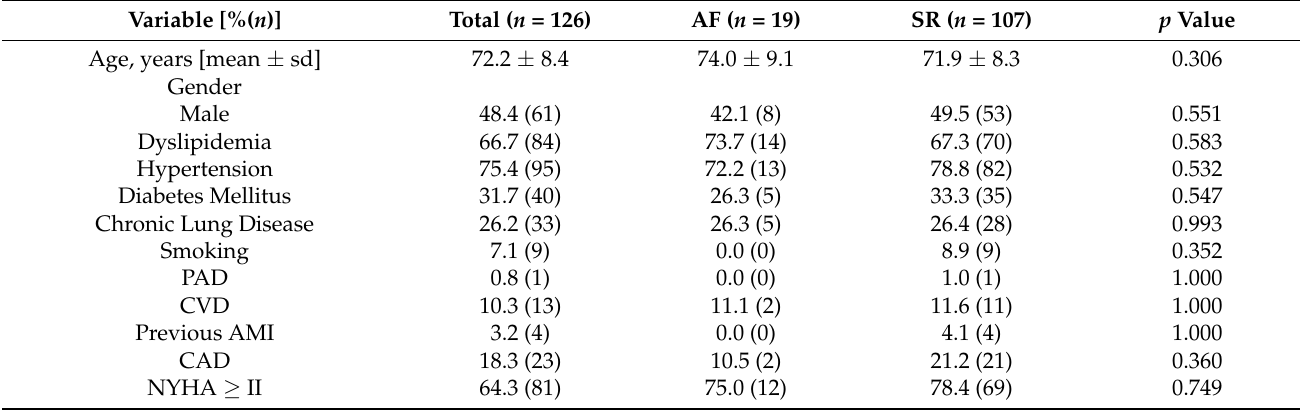
Table 1. Baseline patient